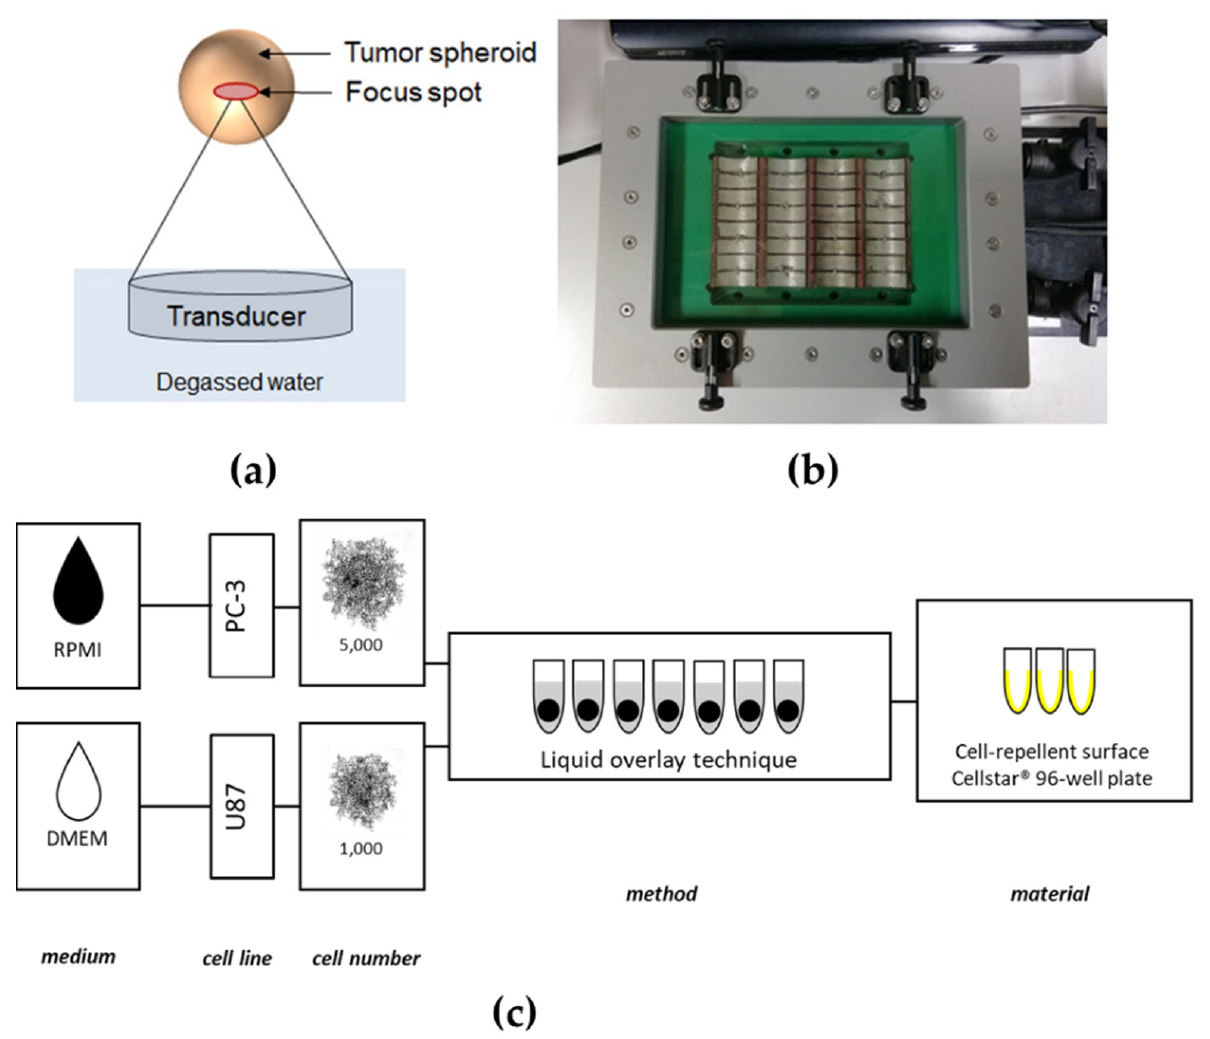
Figure 1. FUS treatment system and generation process of tumour spheroids. ( a ) Scheme of the in vitro FUS transducer and spheroid treatment. ( b ) The FUS in vitro system was specially designed for 96-well cell culture plates, with 32 transducers at a frequency of 1.1 MHz and water cooling. ( c ) The layer of the spheroid formation process for dedicated cancer cell lines. The prostate cancer cell line PC-3 and glioblastoma U87 were cultured in a dedicated medium using a liquid overlay technique to generate tumour spheroids.